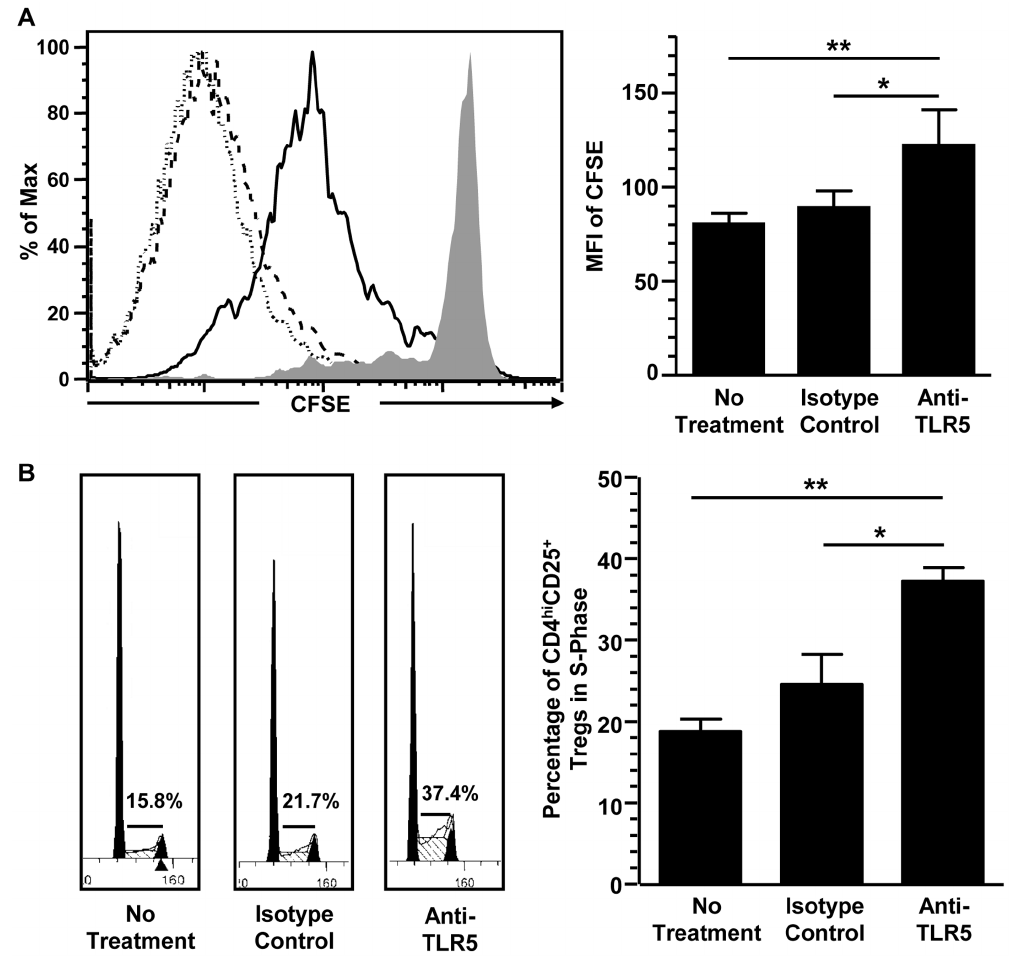
Figure 2. The blockade of TLR5 reduced CD4 hi CD25 + regulatory T cells proliferation by inducing S phase arrest. (A) Flow cytometric analysis of the CFSE signal in CD4 hi CD25 + regulatory T cells generated with no treatment (dotted line), with isotype-matched mAb (dashed line), and with anti-TLR5 blocking mAb (solid line). Filled histogram is the CFSE signal on Day 0 (left panel). Statistical analysis of the MFI of the CFSE in CD4 hi CD25 + regulatory T cells. Data show Mean + SEM, n =6. (right panel). (B) Cell cycle analysis of CD4 hi CD25 + regulatory T cells generated with no treatment (left), with isotype-matched mAb (middle), and with anti-TLR5 blocking mAb (right). Numbers indicate the percentage of CD4 hi CD25 + regulatory T cells in S phase (left panel). Statistical analysis of percentage of CD4 hi CD25 + regulatory T cells in S phase. Data show Mean + SEM, n =6 (right panel). All data shown are representative from three independent experiments. * p , 0.05, ** p , 0.01, one way ANOVA with Tukey’s pairwise